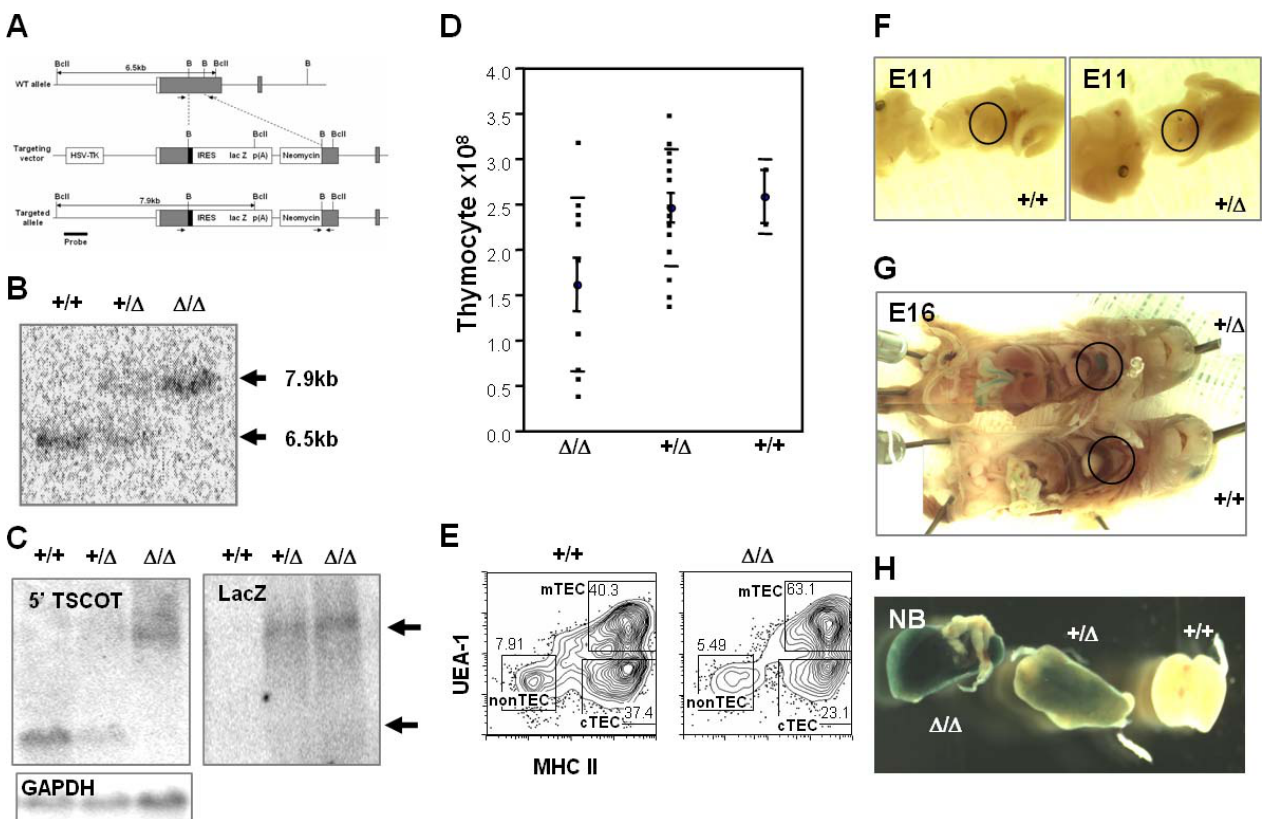
Figure 1. Targeting LacZ into the TSCOT Locus for Expression in Thymic Epithelium (A) Schematic presentation of þ / þ (top), the targeting construct (middle), and the targeted allele (bottom). The restriction sites BclI (BclI) and BamHI (B) and location of coding regions are shown. The probe (627 bp) used in the Southern blot is shown as a thick line under the targeted allele. PCR typing primer positions are shown as small arrows. (B) Southern blot of a BclI digest. The þ / þ allele is 6.5 kb, and the targeted allele is 7.9 kb. (C) Northern blot for the TSCOT-LacZ fusion message. The probe (TSCOT, LacZ, and GAPDH control) is at the top left. (D) Total thymocyte yields from D / D , D / þ , and þ / þ . Averages and standard deviations are shown. (E) Thymic stromal cell analyses of wild type and homozygotes. CD45 (cid:2) gates of 2-wk-old thymuses are shown for MHCII and UEA-1. The cTEC, mTEC, and nonTEC gates are indicated. (F and G) b -gal activity in the developing thymus (E11 and E16, respectively) of fetuses from D / þ and þ / þ littermates. Only the targeted thymus was stained (within the black circles). Endogenous b -gal activity was detected in the intestines of both mice. (H) Newborn thymuses from D / D , D / þ , and þ / þ littermates show a gene dose-dependent expression.